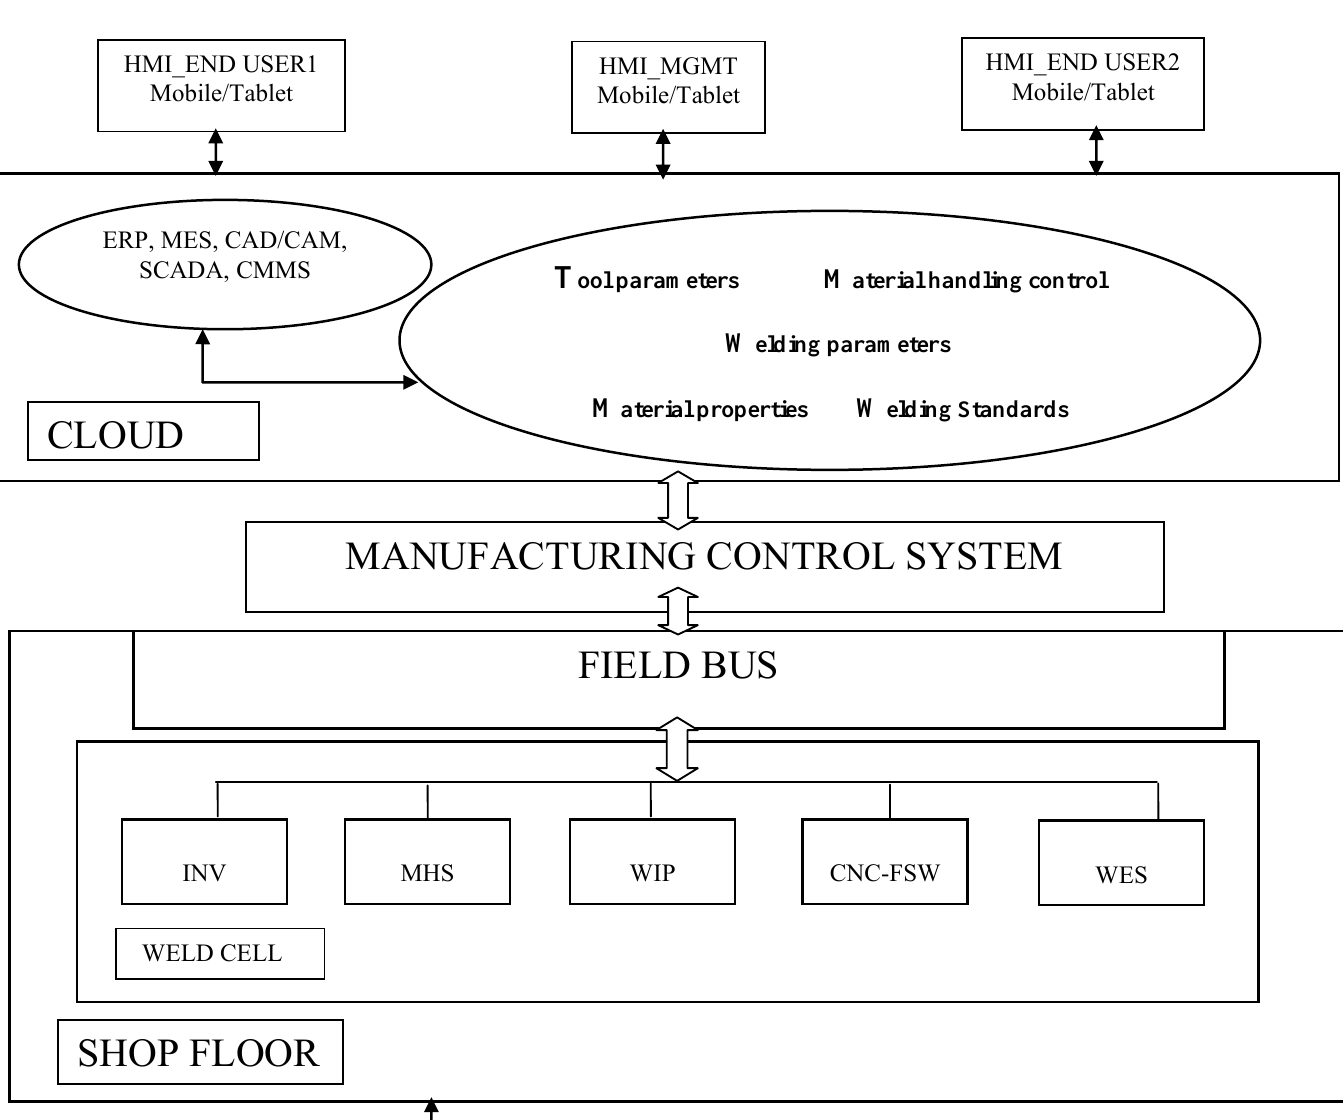
Fig. 5 Proposed MCaaS (Machine Control as Service) of Automated FSW